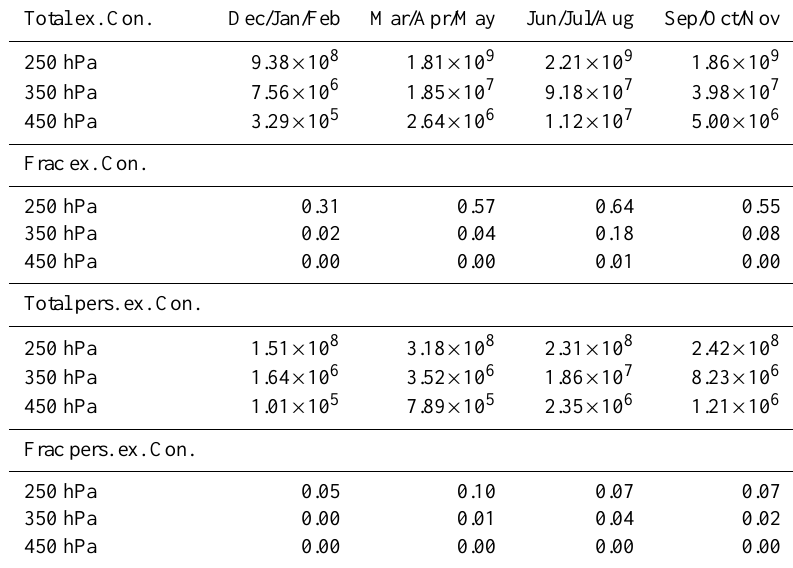
Table 3. Flight distances with exhaust contrails and persistent exhaust contrails: 1st part – flight distances with exhaust contrails in km; 2nd part – fractions of flight distances with exhaust contrails; 3rd part – flight distances with persistent exhaust contrails in km; 4th part – fractions of the total flight distances where exhaust contrails would be